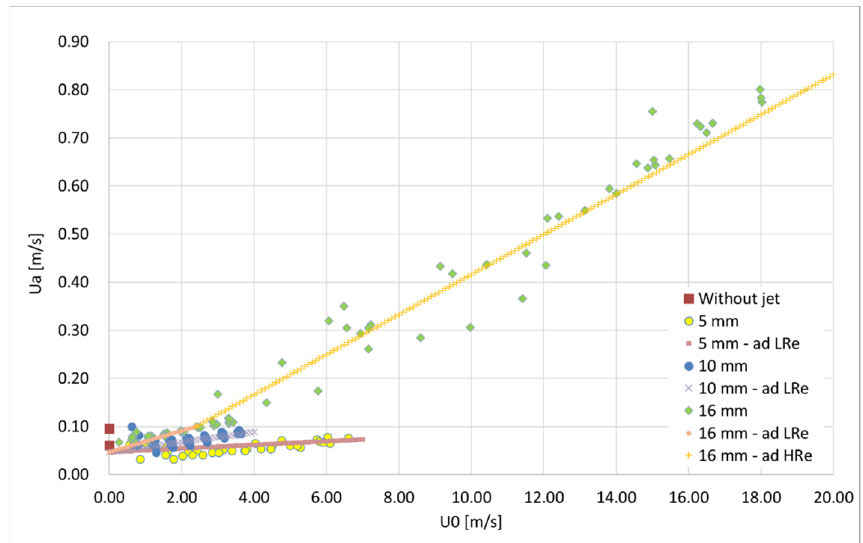
Figure 16. Comparison of the predictions of Equations (4) and (5) with the test results.